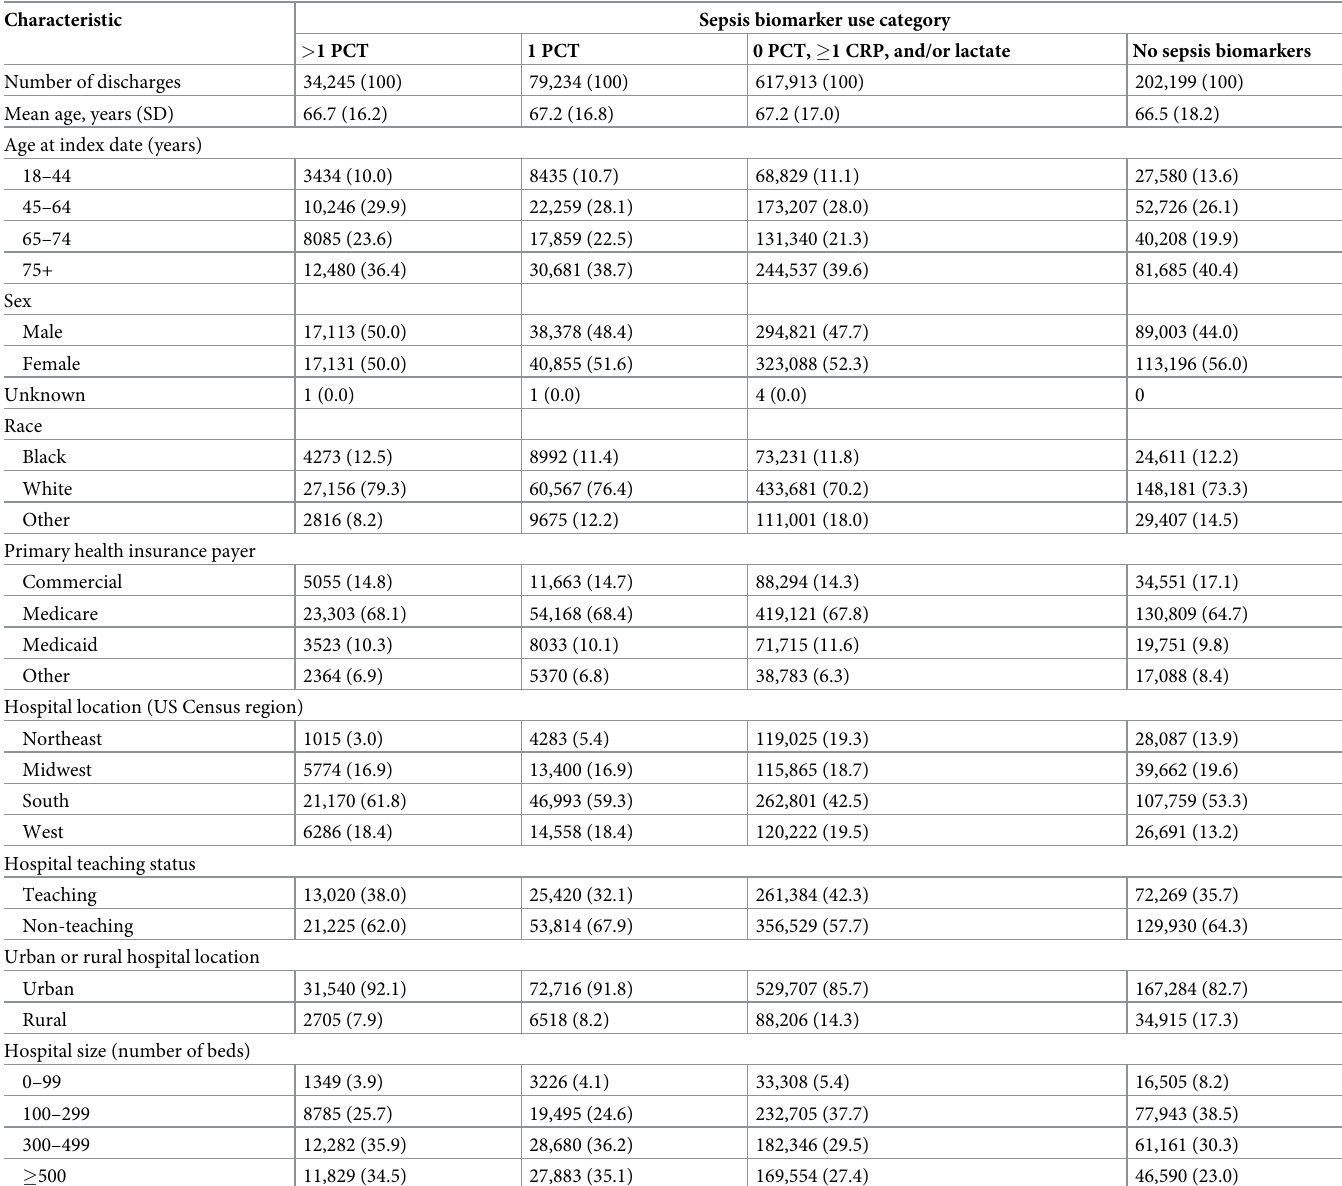
Table 2. Demographic and hospital characteristics for the overall study population (N =